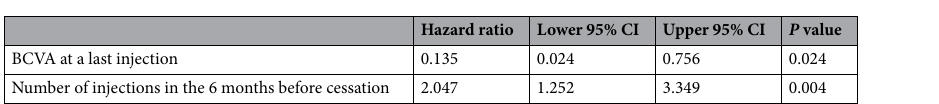
Table 3. Cox proportional hazard analysis of risk factors on recurrence after cessation of treatment in patients with neovascular age-related macular degeneration. BCVA = best-corrected visual